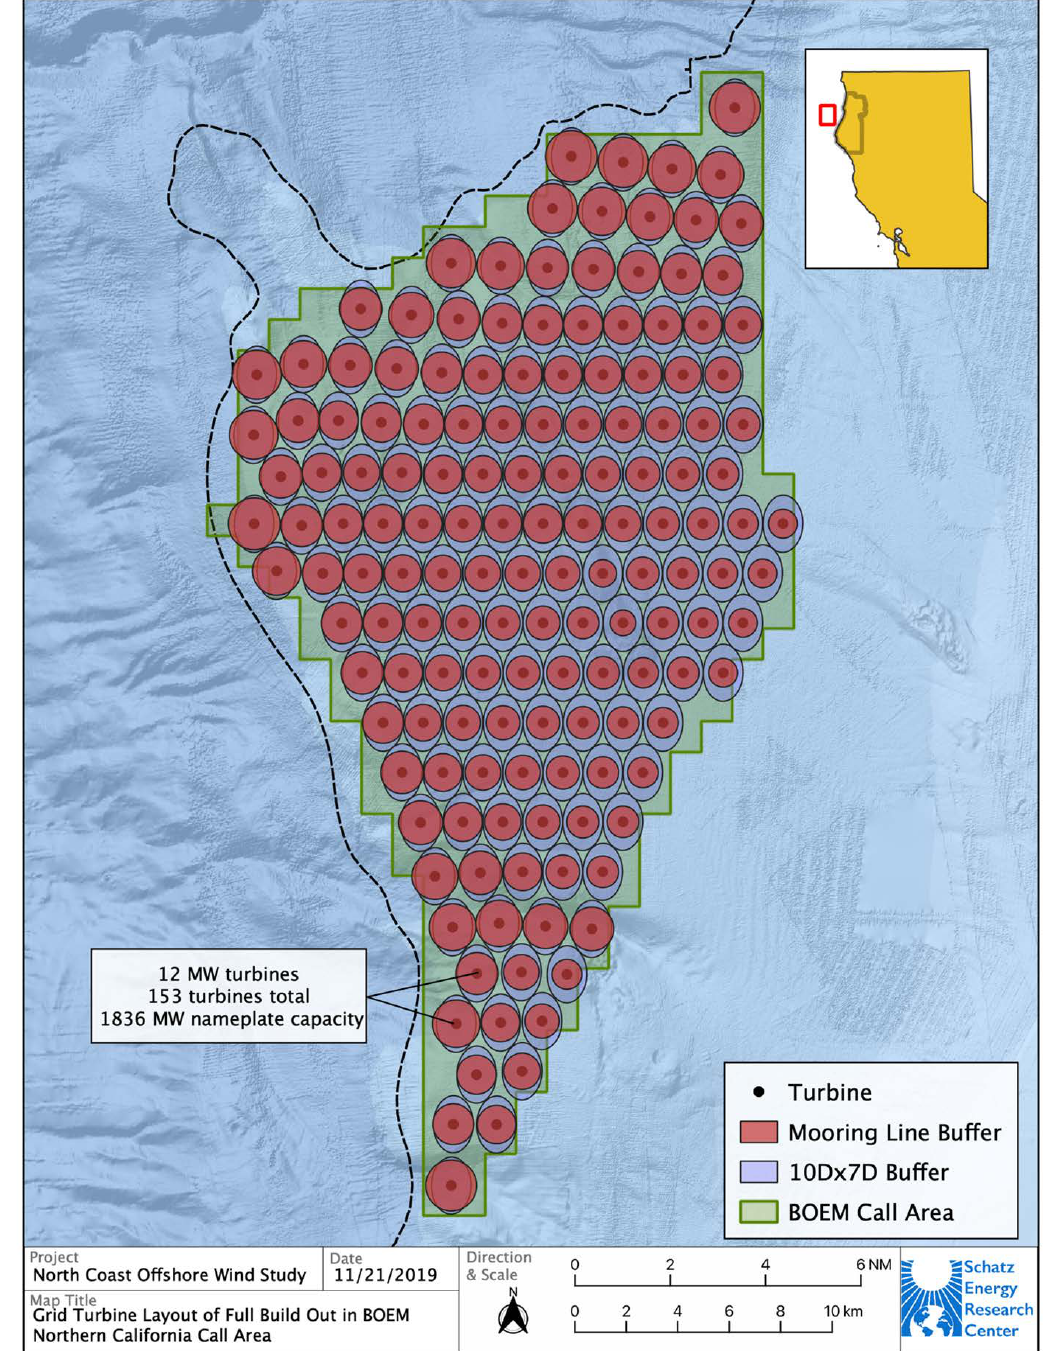
Figure A2. Grid turbine layout of the full-build out scenario in the Humboldt Call